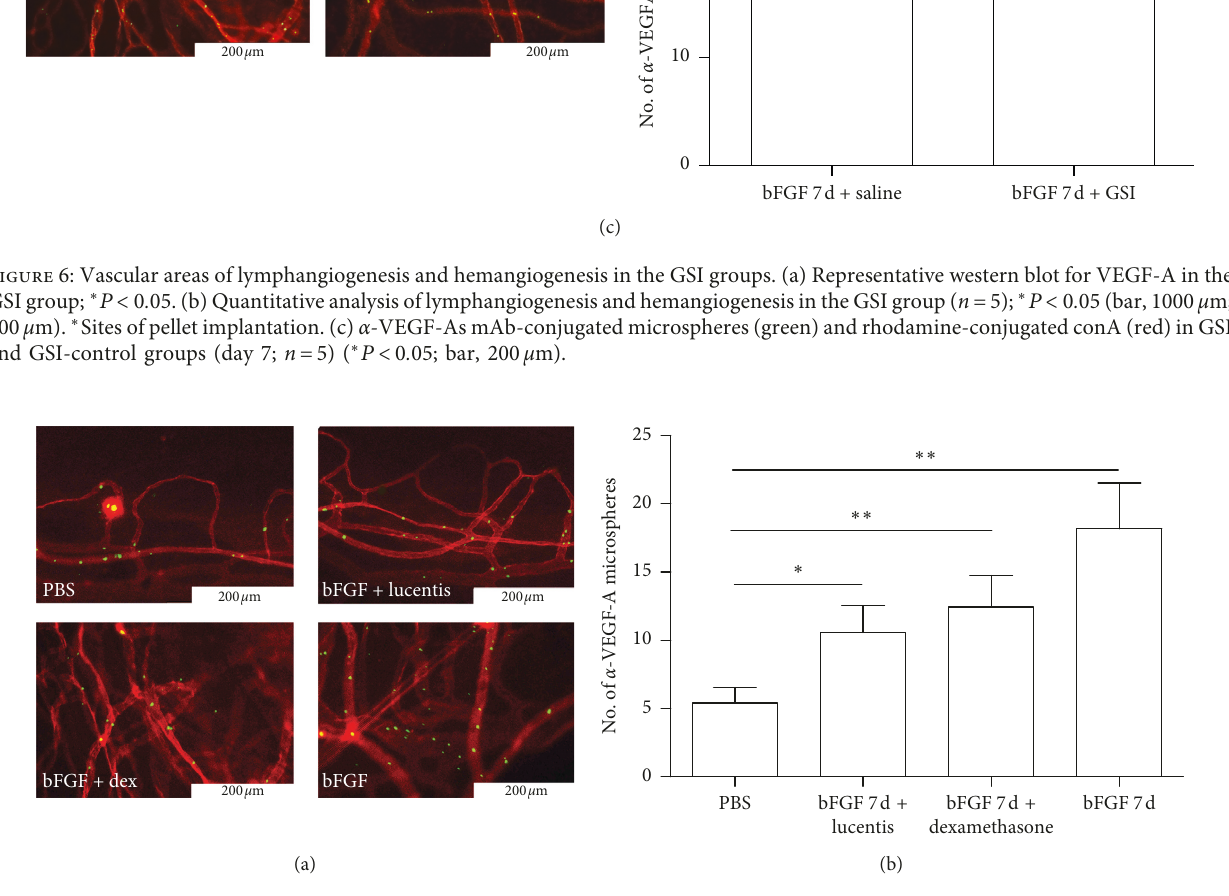
Figure 7: In vivo molecular imaging of α -VEGF-A in bFGF-induced hemangiogenesis. (a) α -VEGF-As mAb-conjugated microspheres (green) and rhodamine-conjugated conA (red) (bar, 200 μ m). (b) Quantitation of the number of α -VEGF-A microspheres ( n � 5–8). ∗ P < 0 . 05; ∗∗ P < 0 .